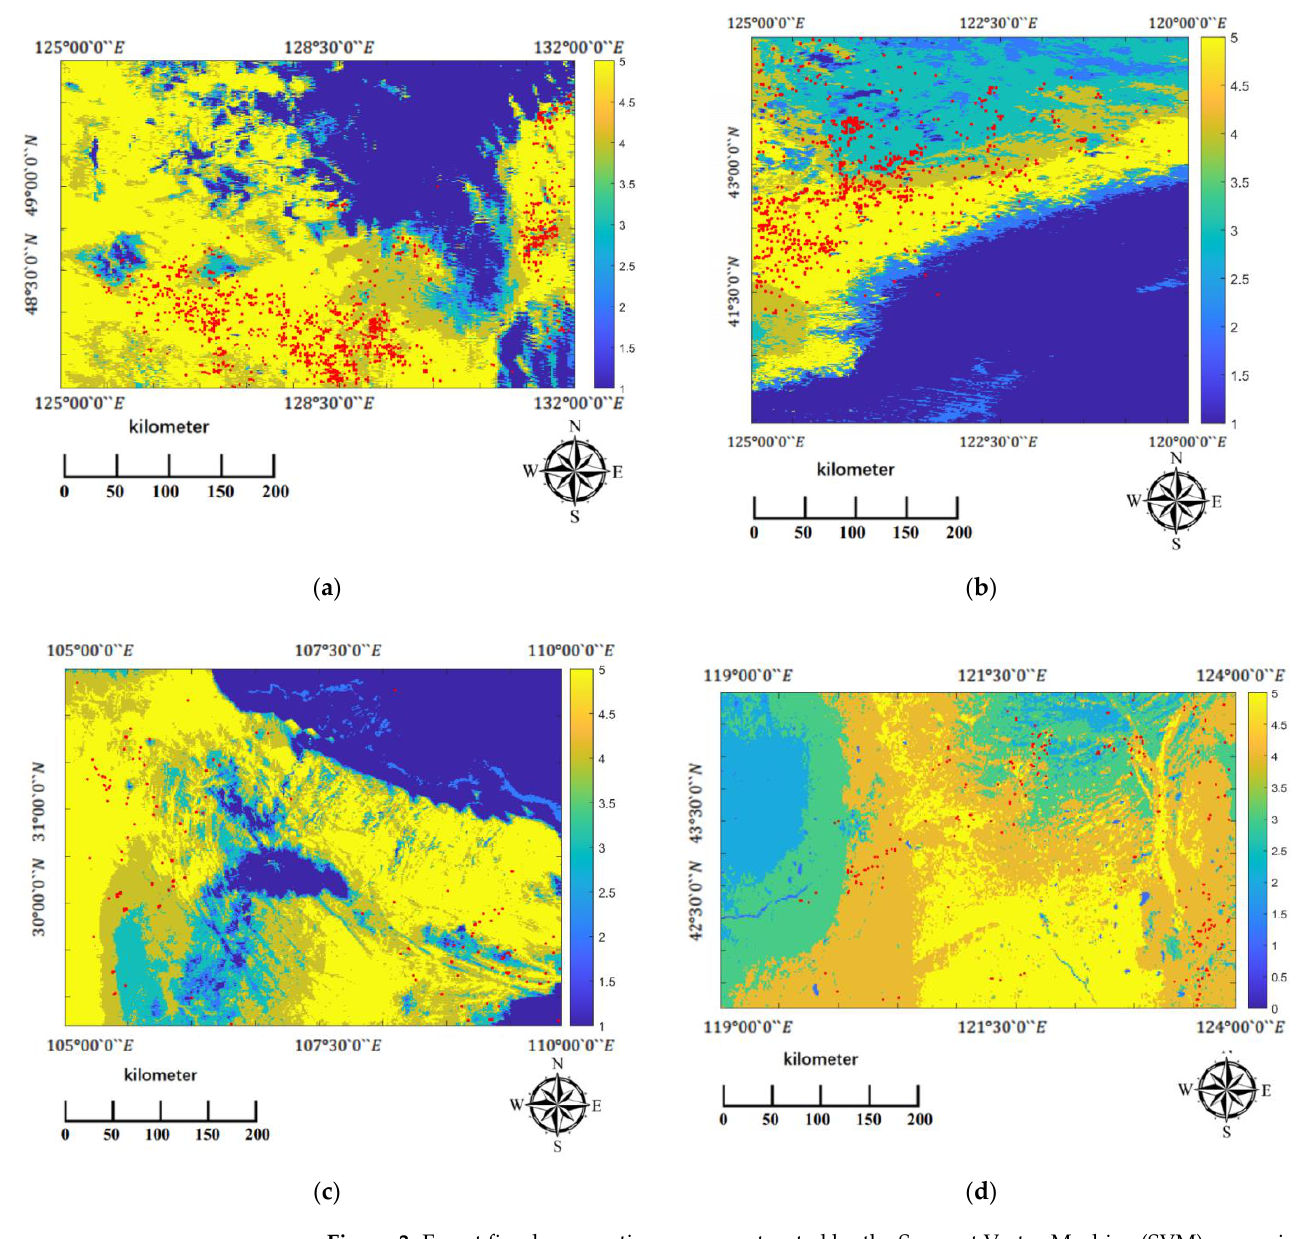
Figure 3. Forest fire danger rating map constructed by the Support Vector Machine (SVM) regression model established in this study. ( a ) Fire risk grade map of the forest area in the southern Greater Khingan Mountains; ( b ) forest area near Hulunber city; ( c ) forest area near Chongqing city; ( d ) forest area near Tongliao city.